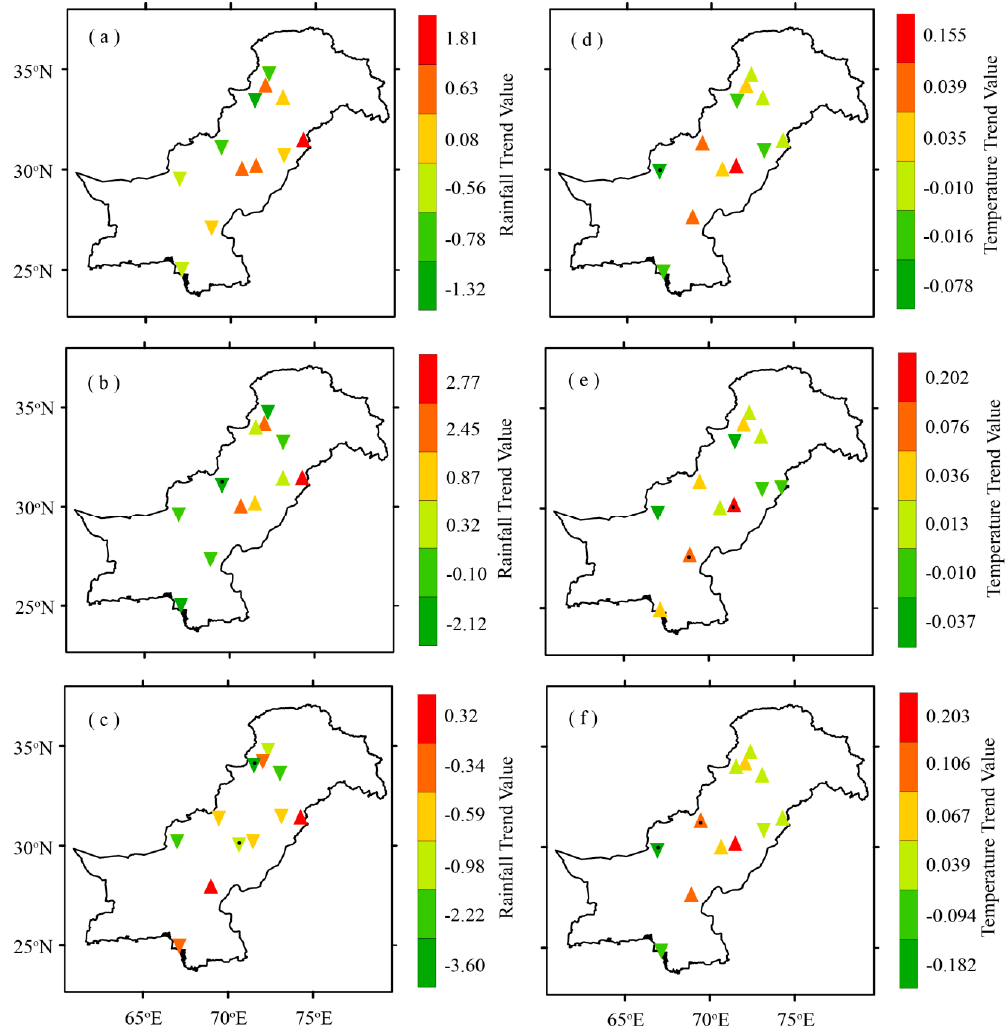
Figure 9. Distribution of annual and seasonal means rainfall (left column) and temperature (right column) trends over the study area during 2003–2017. For rainfall; ( a ) Annual, ( b ) Summer, ( c ) Winter; and for temperature ( d ) Annual, ( e ) Summer, ( f ) Winter based on the data acquired from PMD. The points with central black dots represent statistically significant AOD trends over the selected regions. Magnitudes of trends are listed in table 4.